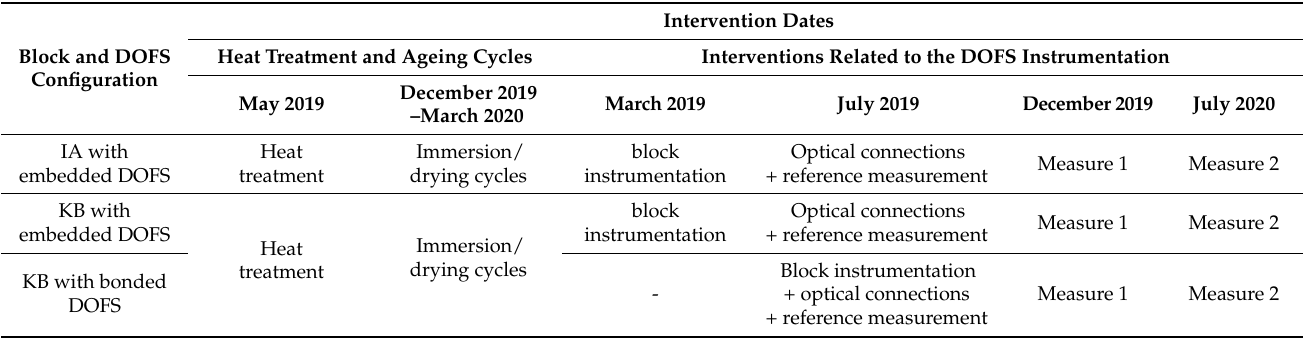
Table 1. Schedule of the different interventions on blocks IA and